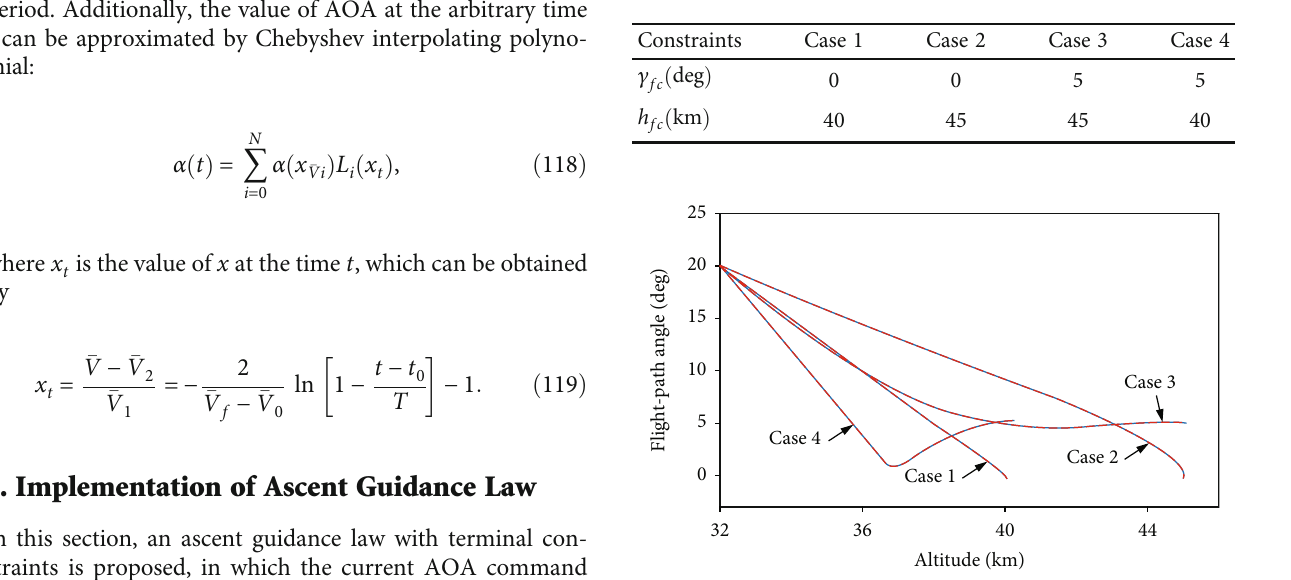
Table 4: Terminal constraints for di ff erent cases.